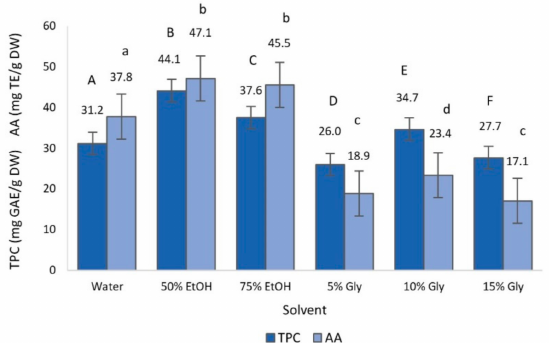
Figure 4. Total phenol content (TPC) and antioxidant activity (AA) of olive leaves extract obtained by microwave-assisted extraction (MAE), as a function of the type of solvent. Different capital and lowercase letters above the bars represent groups significantly different at p < 0.05 of TPC and AA,